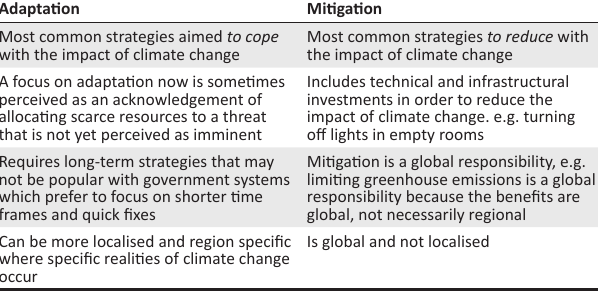
TABLE 1: Difference between adaptation and